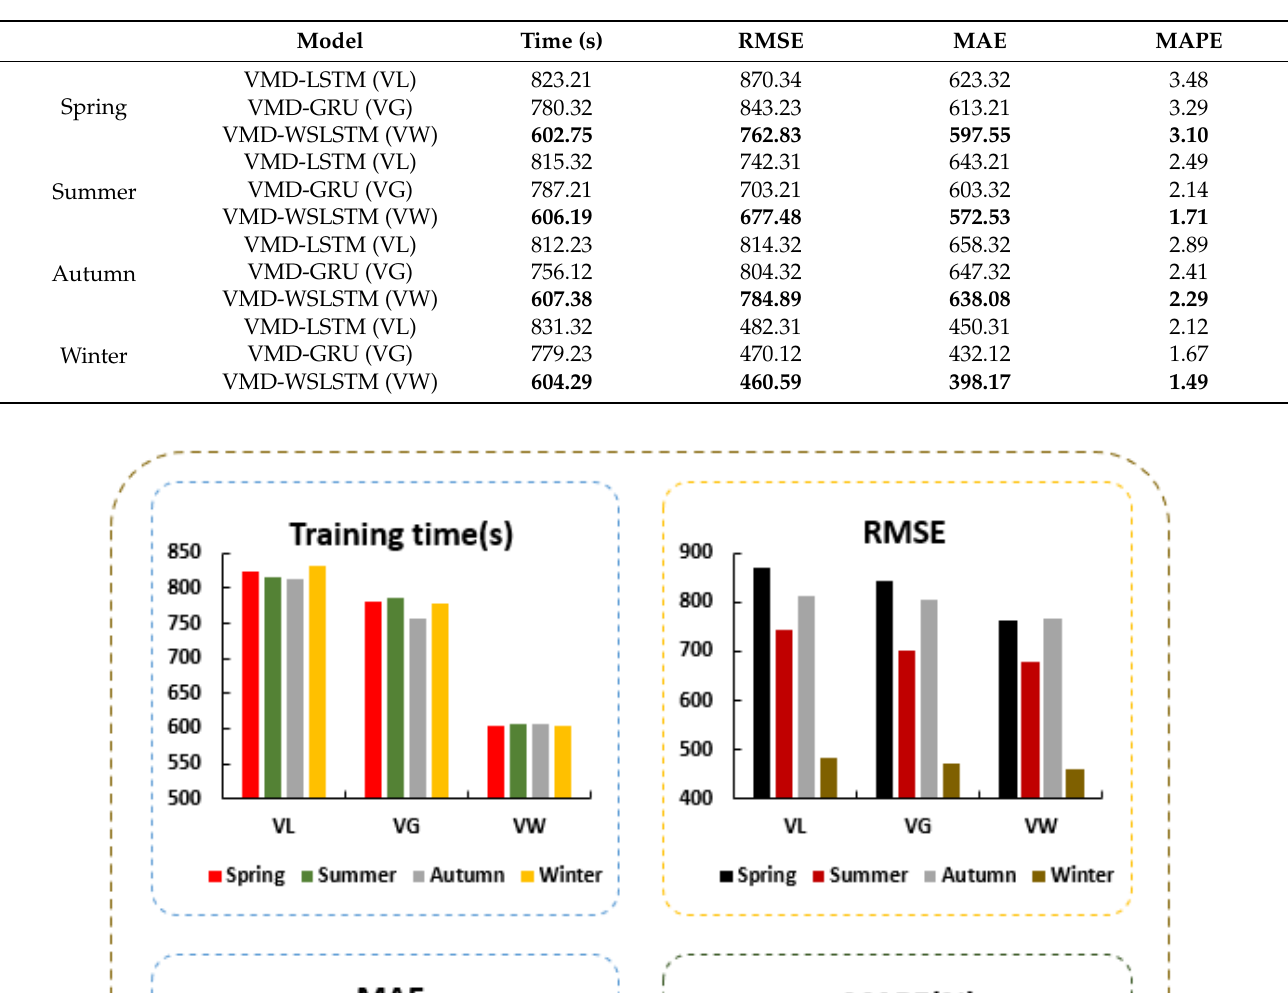
Table 9. Prediction results of different prediction models. Models